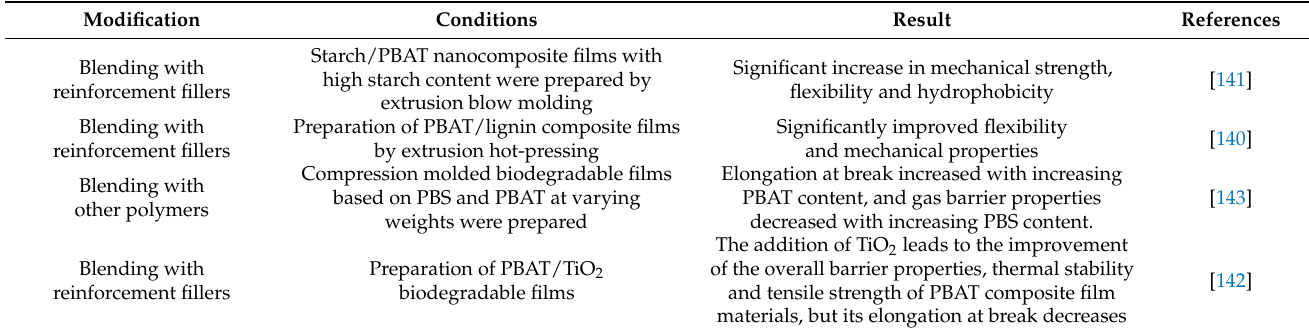
Table 8. The different modifications of PBAT film